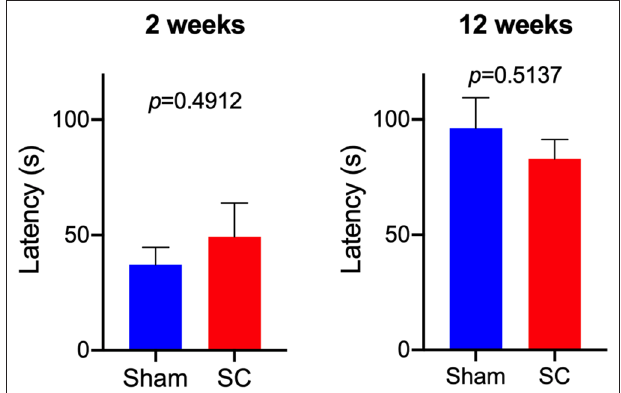
FIGURE 3 | Rotarod Test. Rotarod test was used to compare the neuromotor performance between Sham and Sub-concussion (SC) group rats following 2 or 12 weeks of repeated sub-concussions. The mean latency that the rats were able to stay on the accelerating rod was expressed as a mean ± SEM of 3 trials. Statistical significance was assessed with unpaired t -test or non-parametric Mann-Whitney